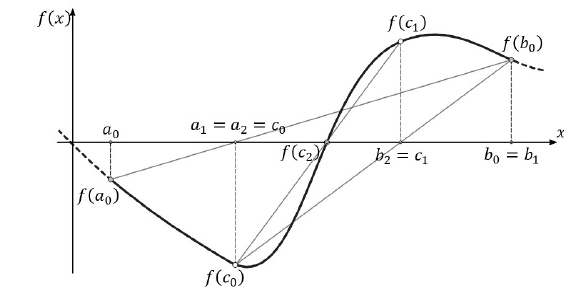
Figure 10. Solution strategy of the false position